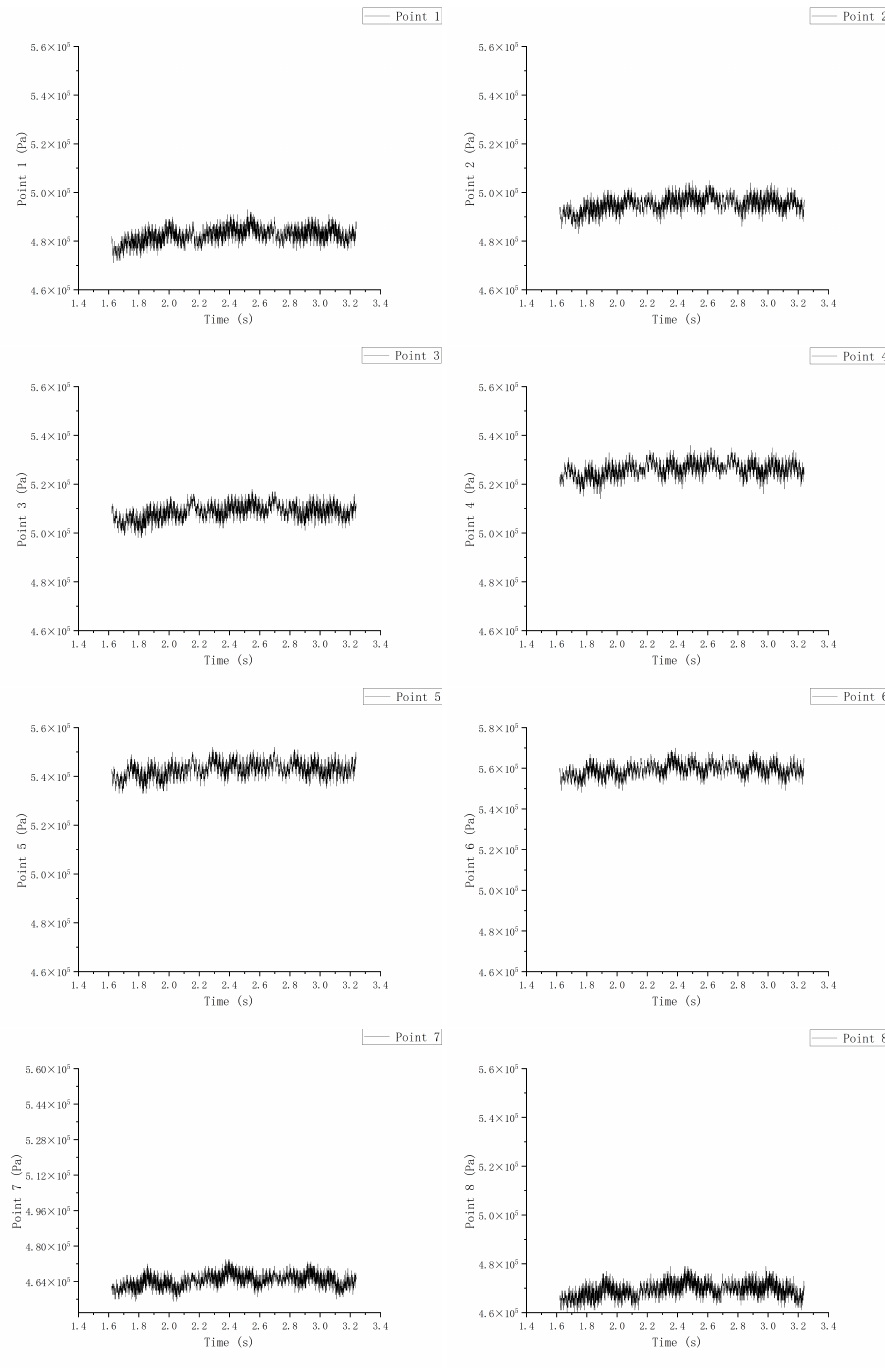
Figure 23. The pressure distributions of the lower